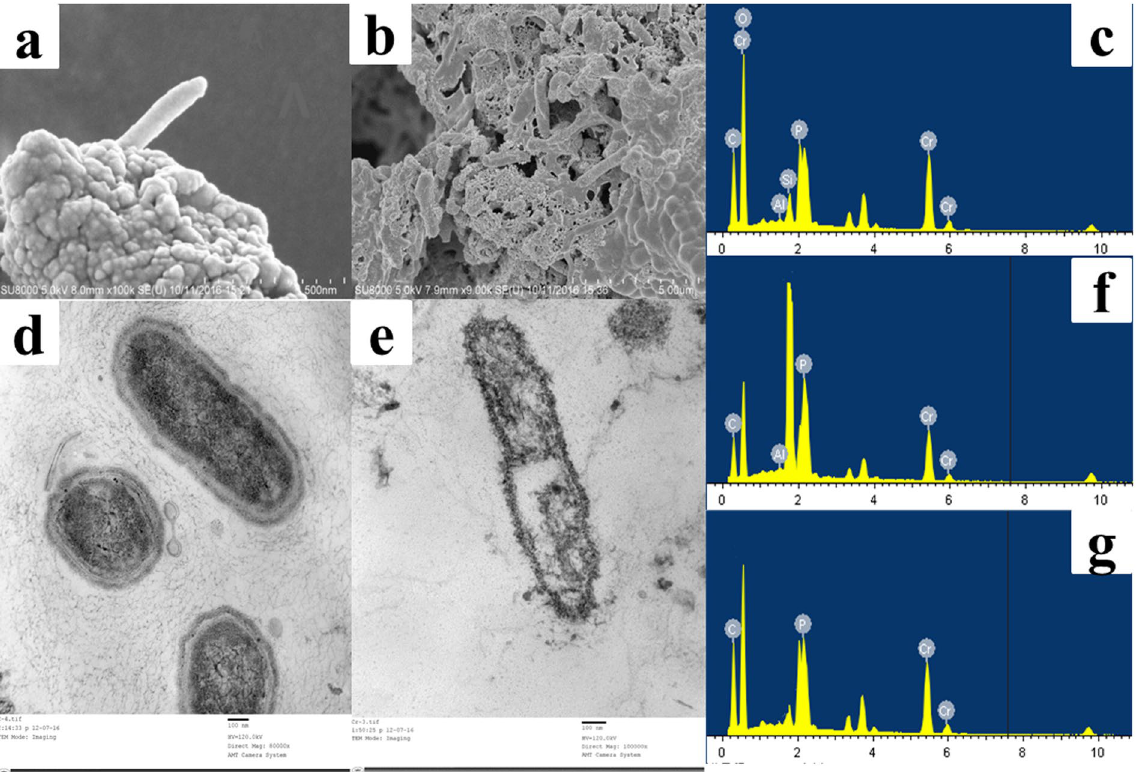
Figure 2. Morphology and element analyses. ( a ) SEM of the activated sludge without Cr(VI); ( b ) SEM of the activated sludge with Cr(VI); ( c ) EDS for the sludge with Cr(VI); ( d ) TEM of the activated sludge without Cr(VI); ( e ) TEM of the activated sludge with Cr(VI); ( f ) and ( g ) EDS for the TEM outside and inside of cell with Cr(VI), respectively. Samples were taken at Day 10 and Day